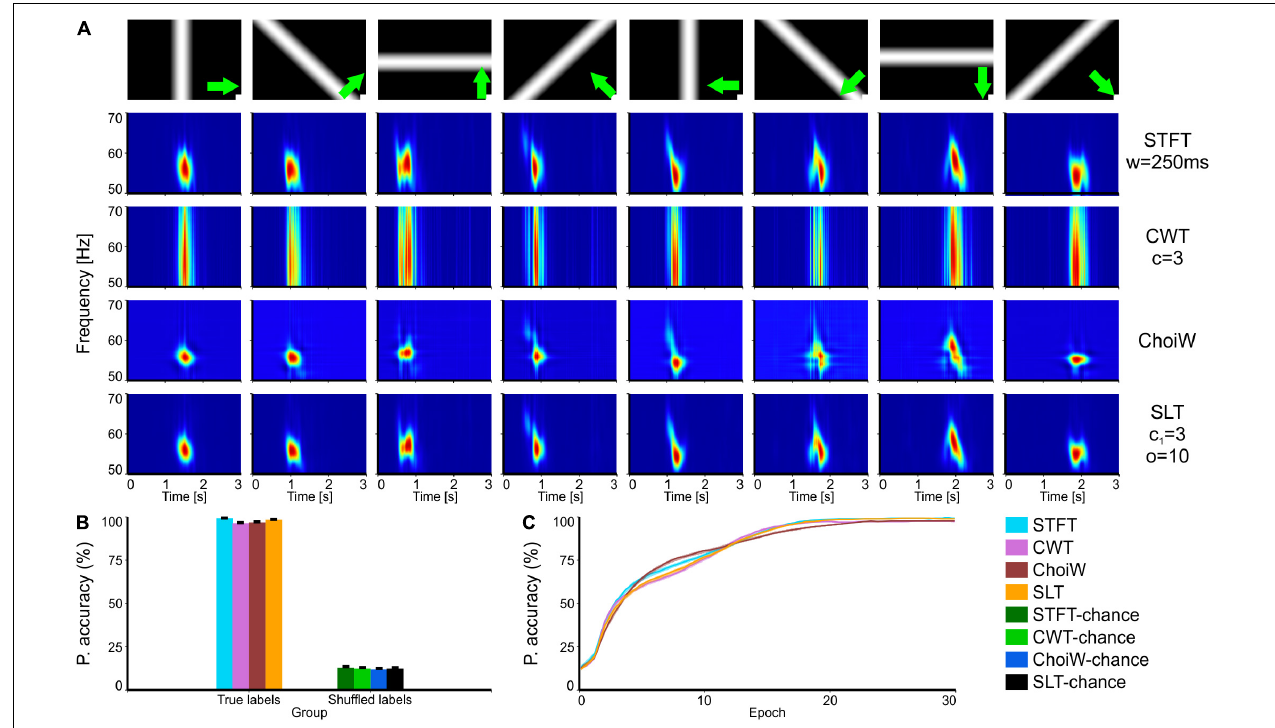
FIGURE 2 | Intracranial electrophysiology with RF visual stimulation protocol. (A) Table of TFRs where each column corresponds to a particular grating direction (condition) and each row corresponds to one of the time-frequency analysis methods. (B) Average accuracy as measured on the validation set (100 network initializations and dataset splits), with original (true) and shuffled labels (for chance level estimation). (C) Learning curves on the validation set for the original labels group (chance level curves were omitted here but reside at ∼ 12.5%). Error bars are